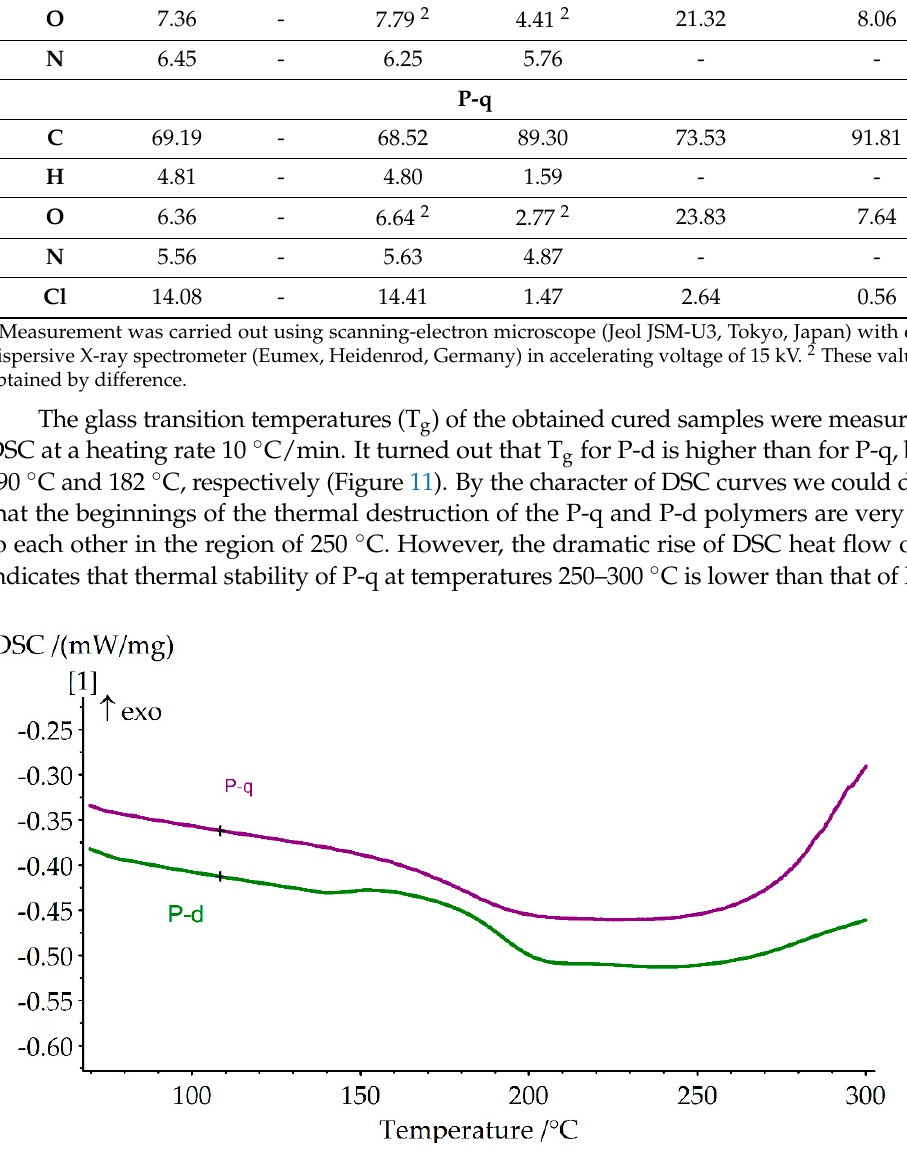
Figure 11. DSC curves of the cured P-q and P-d.